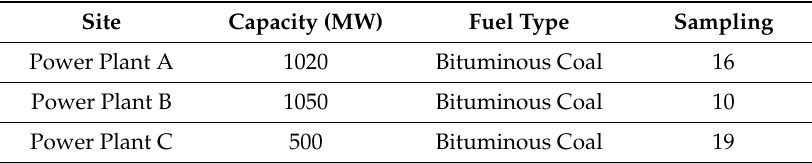
Table 1. Characteristics of the investigated bituminous coal power